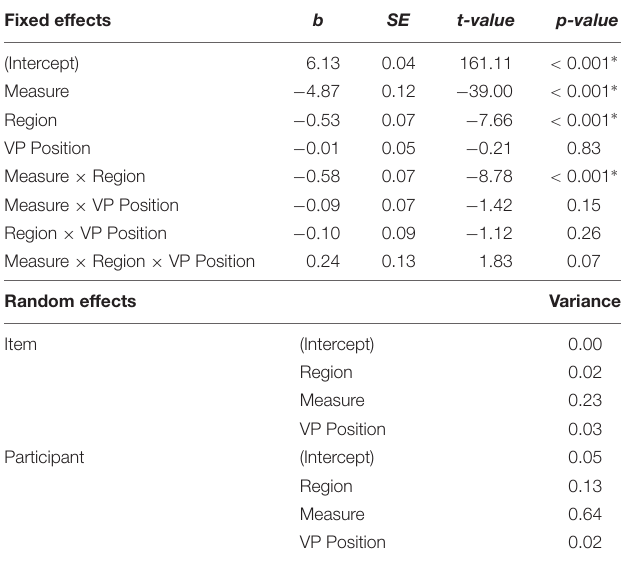
TABLE 2 | Experiment 1, Analysis 1 core model outputs. TABLE 3A | Experiment 1, Analysis 2 item-specific model outputs